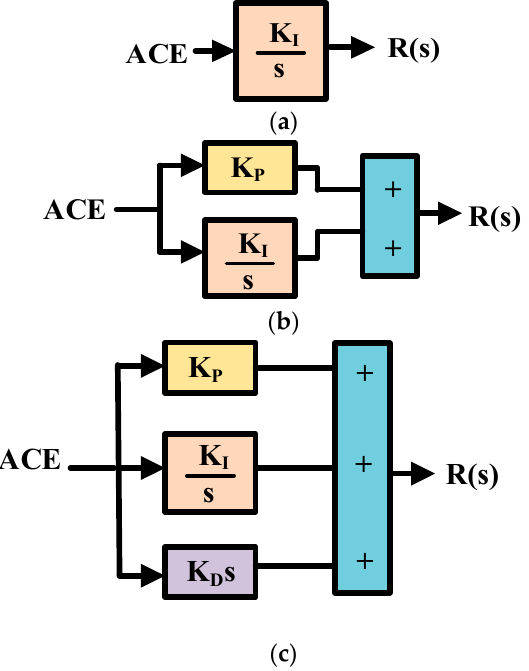
Figure 5. The classical controllers. ( a ) I controller; ( b ) PI controller; and ( c ) PID controller.